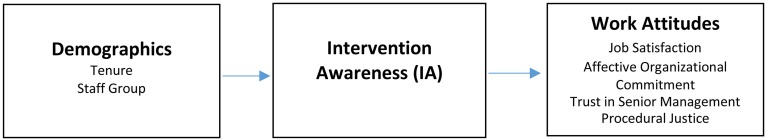
Model for the study.